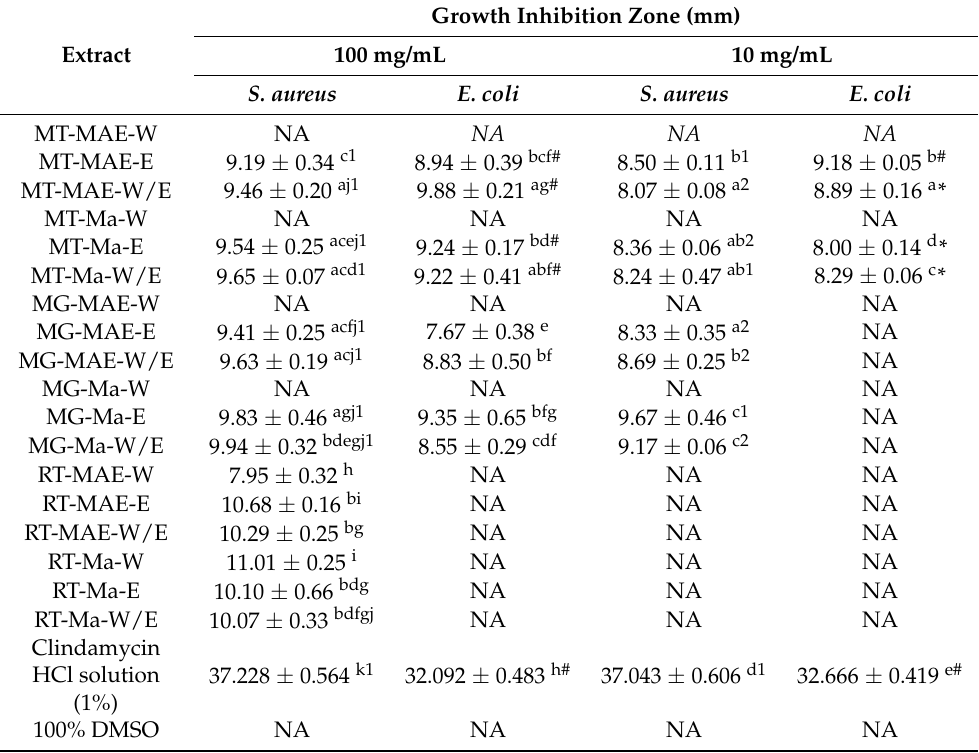
The experiment was performed in triplicate. Mean ± S.D. values in the same column with different letters ( a–j ) indicate a significant difference ( p < 0.05). Values in the same row with different numbers ( 1,2 ) indicate a significant difference ( p < 0.05) of the growth inhibition zones against S. aureus in different concentration. Values in the same row with different symbols ( # ,*) indicate a significant difference ( p < 0.05) of the growth inhibition zones against E. coli in different